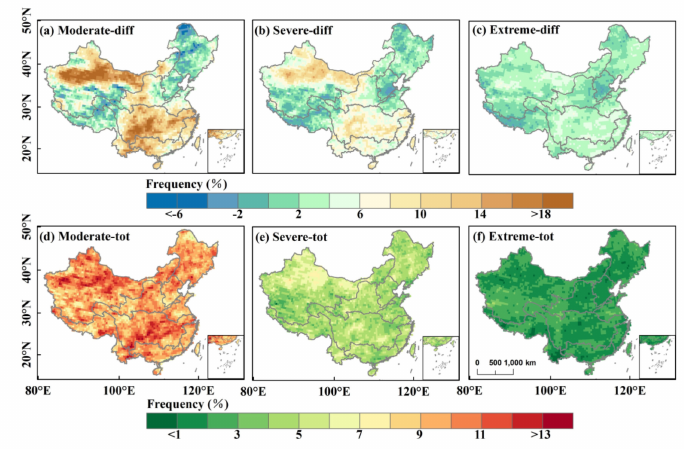
Figure 6. Spatial patterns of differences in the frequency of moderate ( a ), severe ( b ), and extreme drought ( c ) between 1961–1990 and 1991–2014. Spatial distributions of total DF of moderate ( d ), severe ( e ), and extreme drought ( f ) from 1961–2014. The frequency of moderate drought is the ratio between the total months when − 1.5 ≤ SPEI03 < − 1 and the total length of the sequences. The frequency of severe drought is the ratio between the total months when − 2 ≤ SPEI03 < − 1.5 and total length of the sequences. The frequency of extreme drought is the ratio between the total months when SPEI03 < − 2 and the total length of the